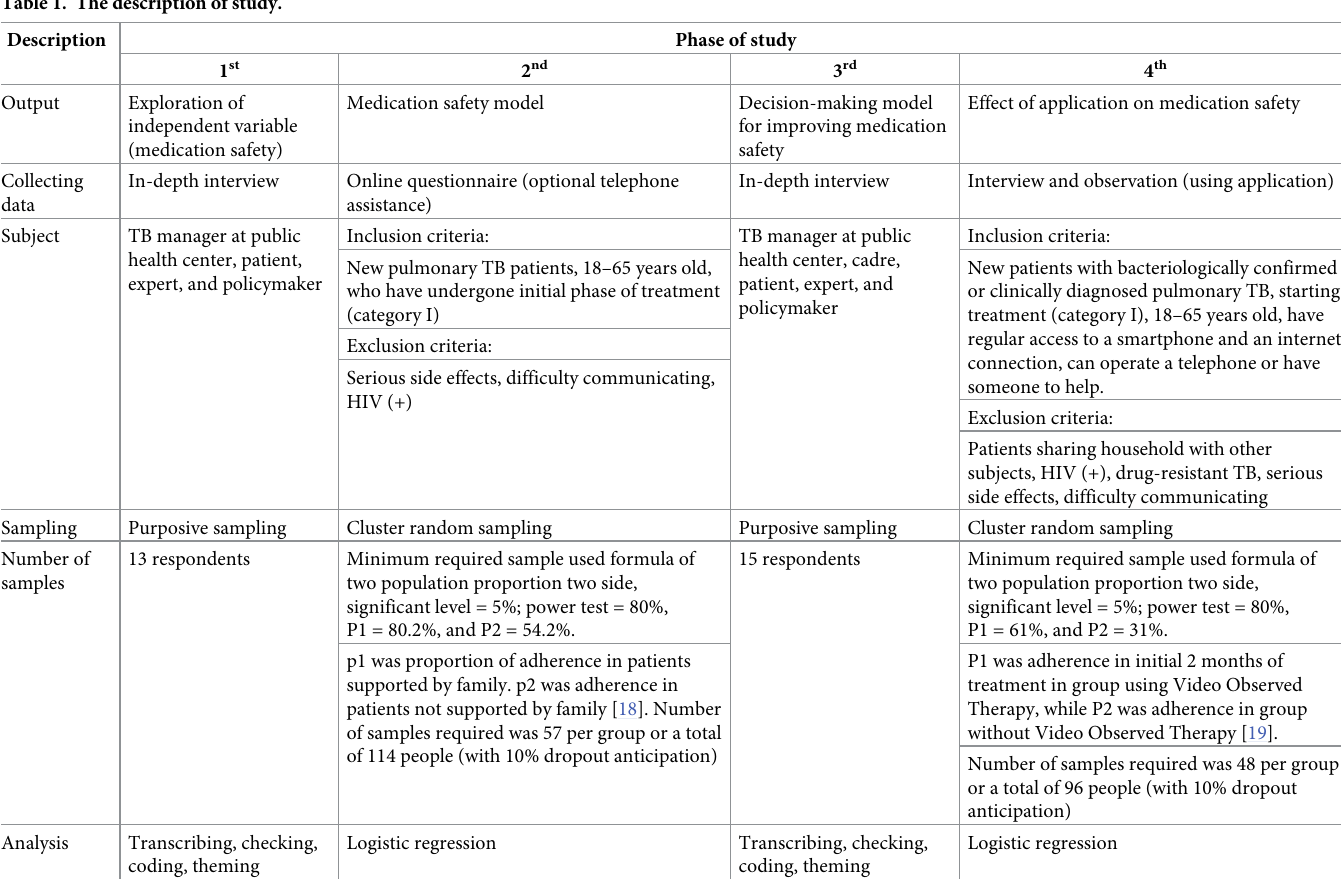
Table 1. The description of